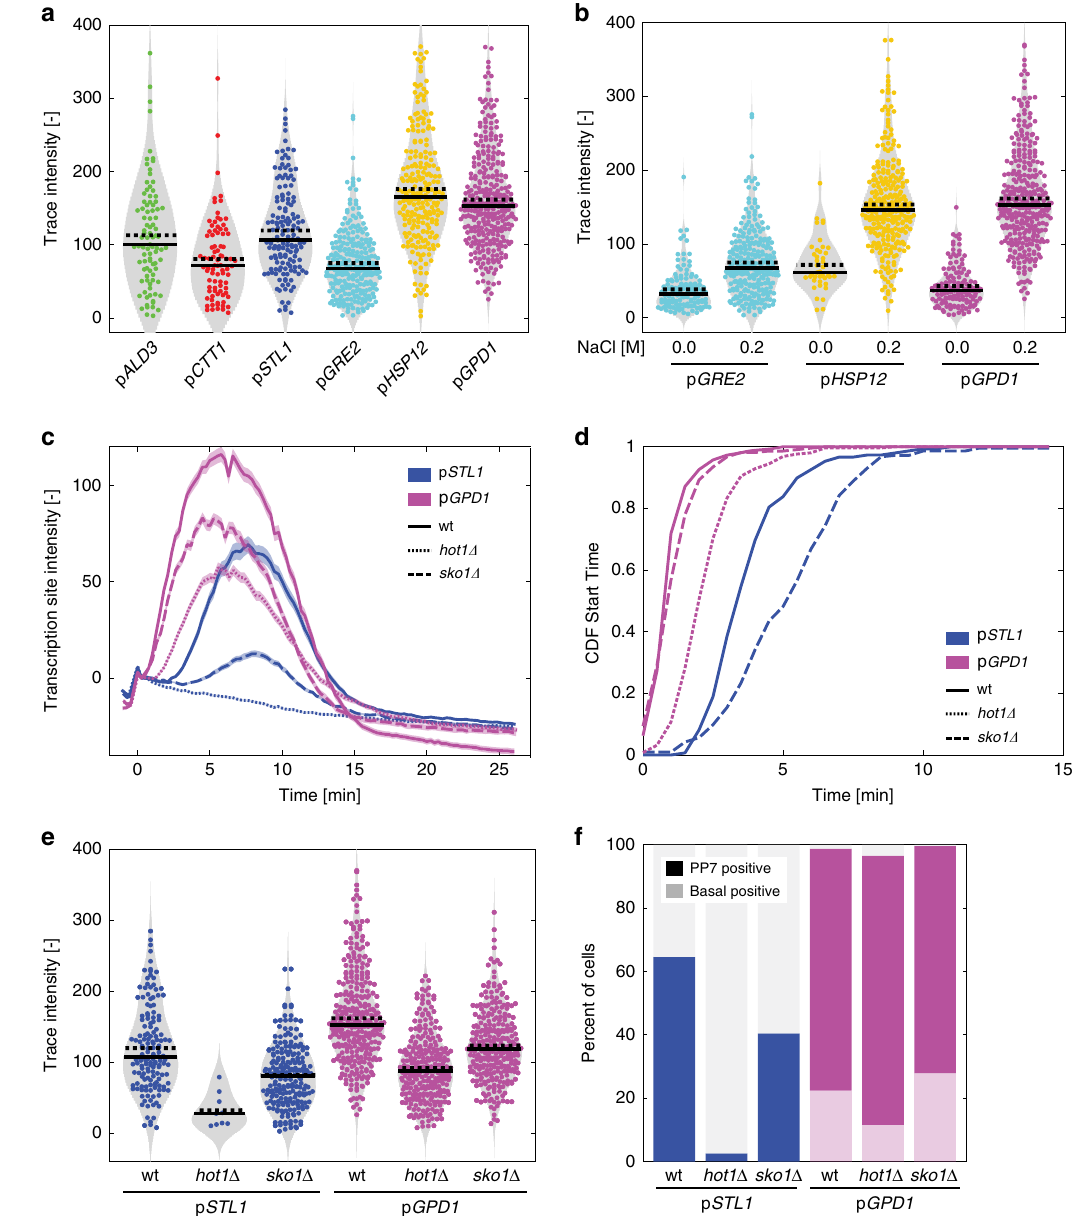
Fig. 4 Transcription factors control the dynamics and level of mRNA production. a Violin plots of the trace intensity (maximum of the TS during the transcription period) for the six promoters after stimulation by 0.2 M NaCl. Each dot represents the value calculated from a single cell. The solid line is the median and the dashed line the mean of the population. b Comparison between the trace intensity in stimulated (0.2 M NaCl) and unstimulated conditions (0.0 M) for the three promoters displaying basal expression. c . – f Effects of the deletions of the HOT1 and SKO1 transcription factor genes on p STL1 and p GPD1 dynamics of transcription ( c , the solid lines represent the mean of the population and the shaded areas represent the s.e.m.), cumulative distribution functions of Start Times ( d ), the trace intensity ( e ) and the percentage of responding cells ( f ) for the p STL1 -PP7sl and p GPD1 -PP7sl reporter strains following a 0.2 M NaCl stress for at least 200 cells. For the p STL1 -PP7sl hot1 Δ sample, 349 cells were analyzed with only 9 displaying a PP7 TS signal. This low number does not allow to draw a meaningful CDF curve in d . Source data are provided for b and c